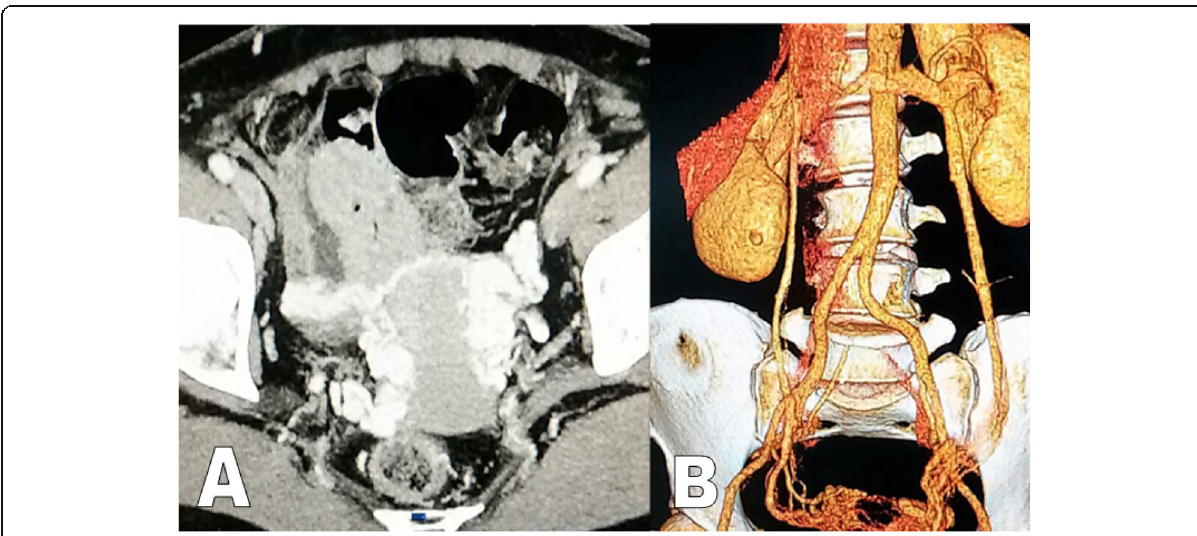
Fig. 1 a Axial CTV of the pelvis showing multiple dilated and congested parametric and ovarian veins. b 3D VR CTV of the abdomen and pelvis showing dilated both ovarian veins along their courses